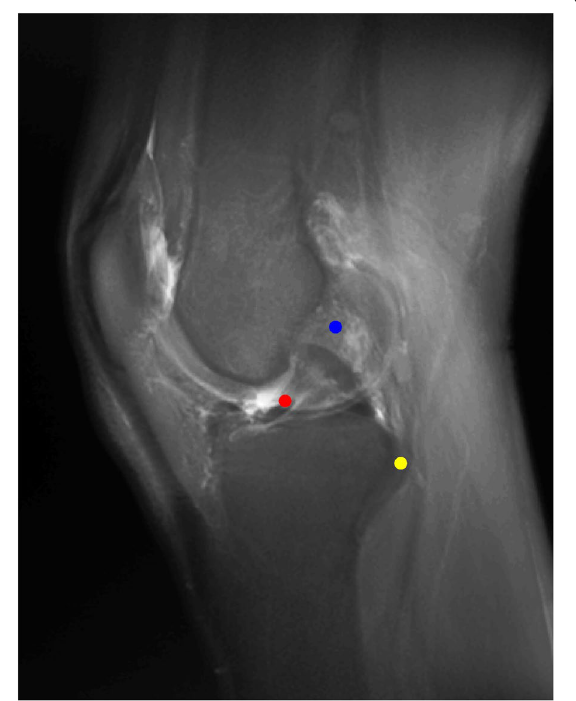
Fig. 7 LAT "CLASS" view (blue point: centroid ACL femoral footprint, red point: centroid ACL tibial footprint, yellow point: the styloid process of fibular